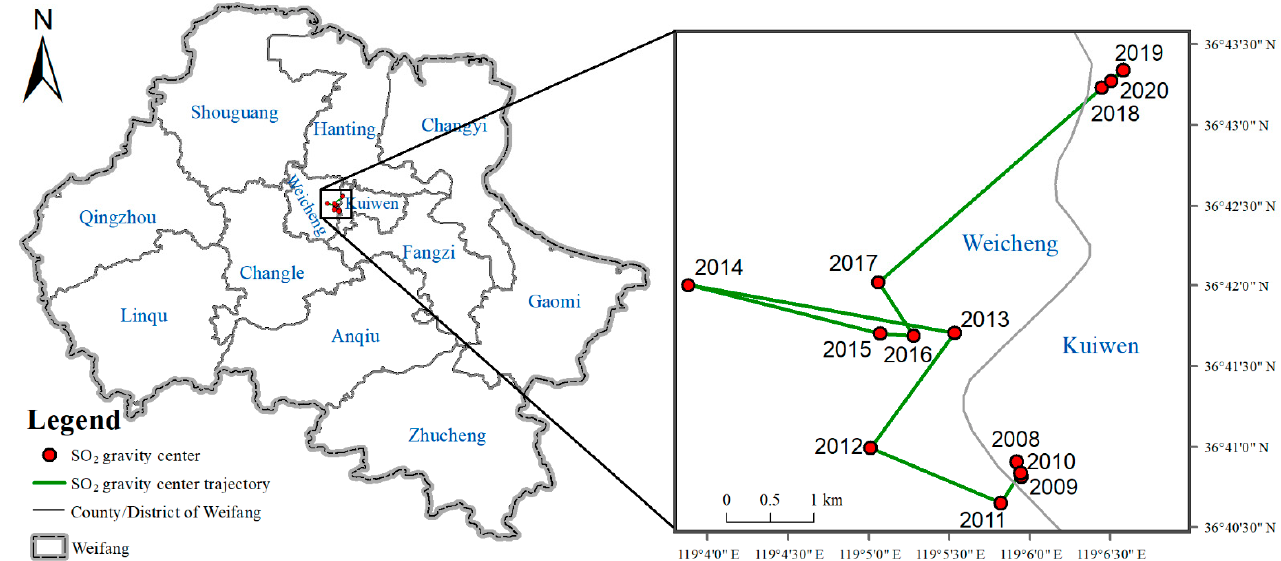
Figure 10. SO 2 center of gravity from 2008 to 2020.